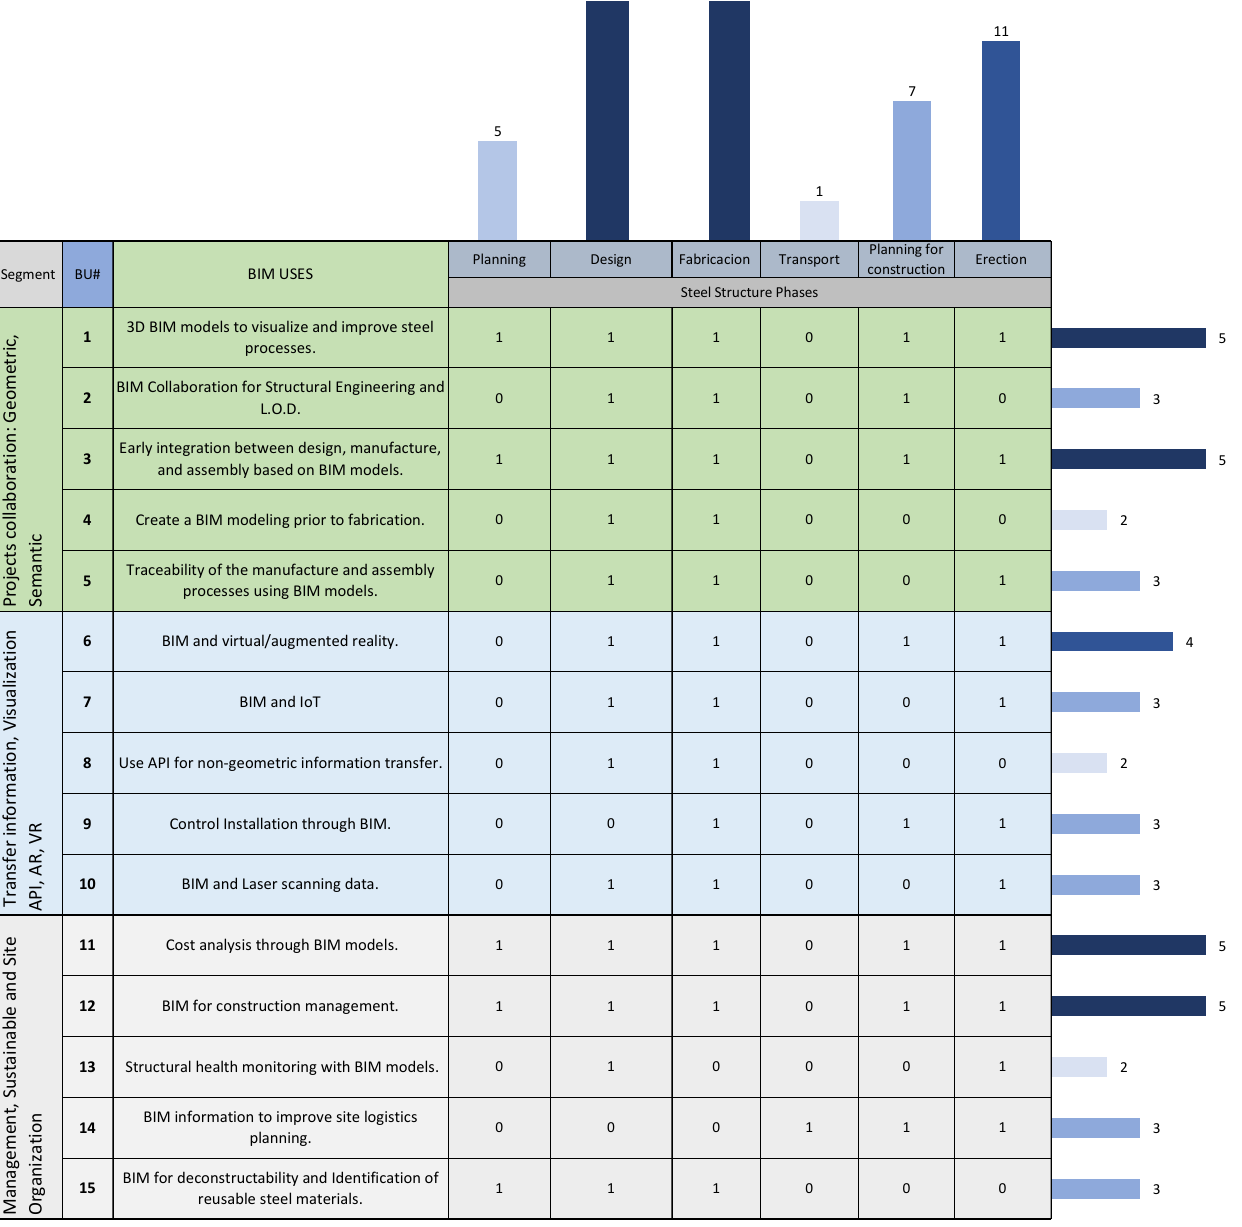
Figure 6. BIM utilization is related to the six project life cycle phases: planning, design, fabrication, transport, planning for construction, and erection.